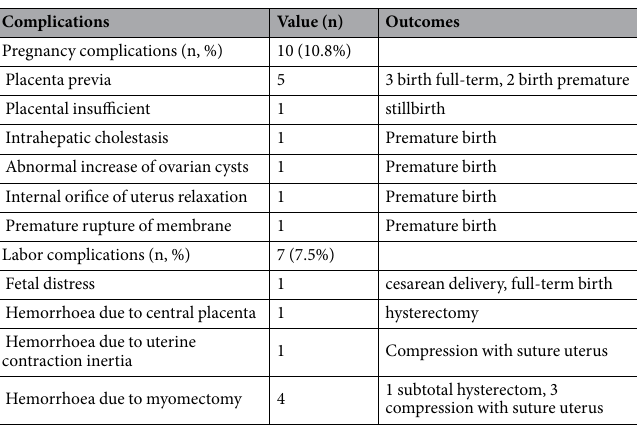
Table 4. Outcomes and details of complications during pregnancy and